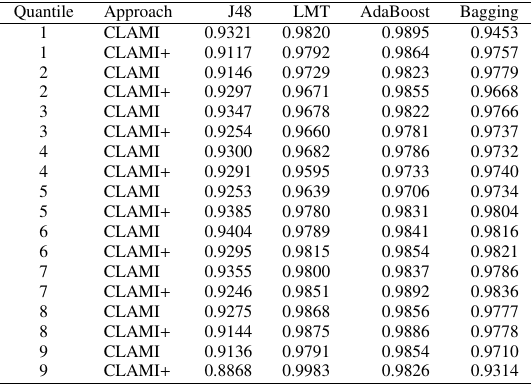
Table 2. Average defect-prone AUC of the ML